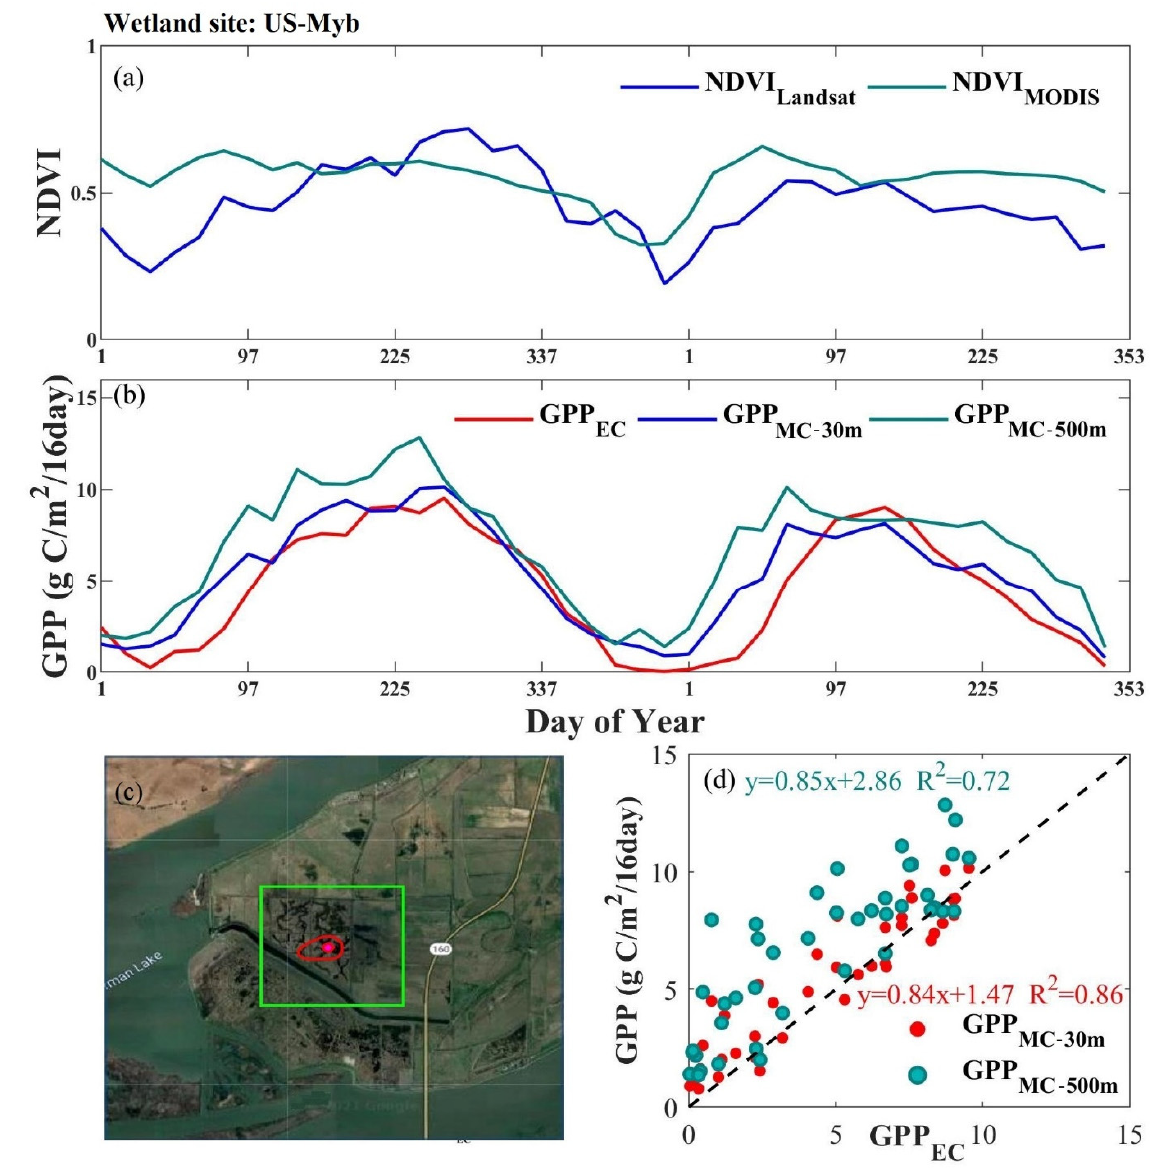
Figure 9. ( a ): The seasonal cycles of NDVI from different sensors. The NDVI_Landsat and NDVI_MODIS correspond to the footprint from Landsat and MODIS, respectively. ( b ): The plot of the simulated GPP (GPP MC-30m and GPP MC-500m ) and tower GPP (GPP EC ). ( c ): The red line represents Landsat footprint of the US-Myb site extracted by the 30 m spatial resolution pixel (Landsat). The green rectangle is the footprint of the US-Myb site extracted by the 500 m spatial resolution pixel (MODIS). ( d ): The relationship of GPP MC-30m , GPP MC-500m , and tower GPP (GPP EC ).